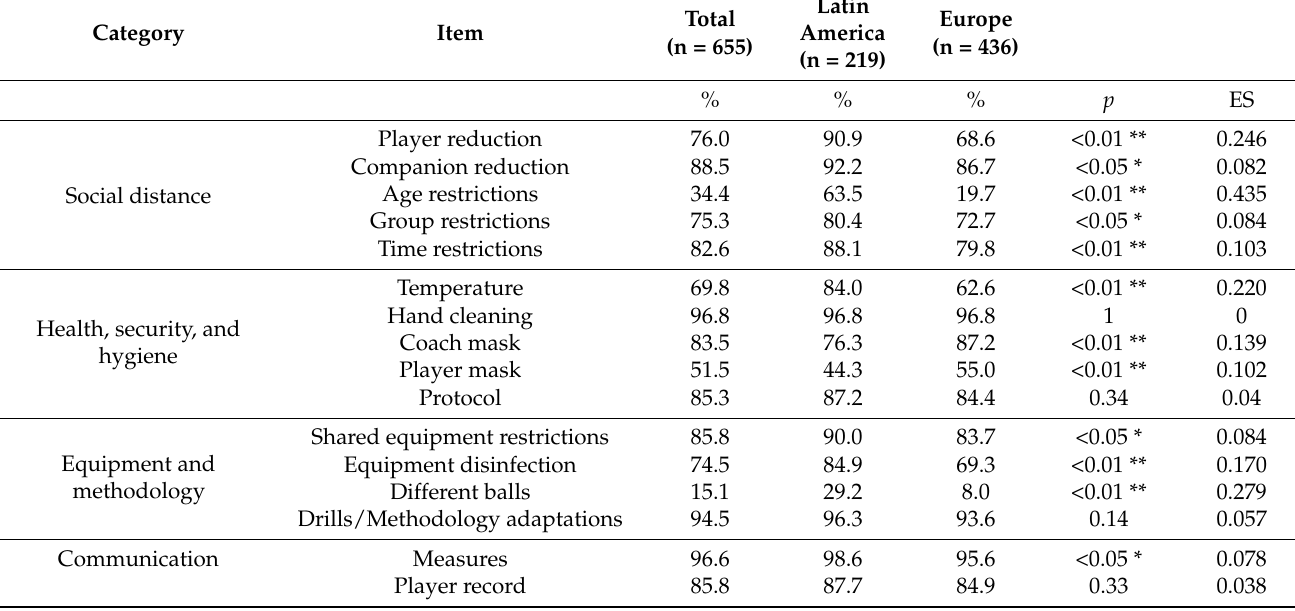
Table 2. Percentage of coaches who carried out the measurements for each of the categories according to the